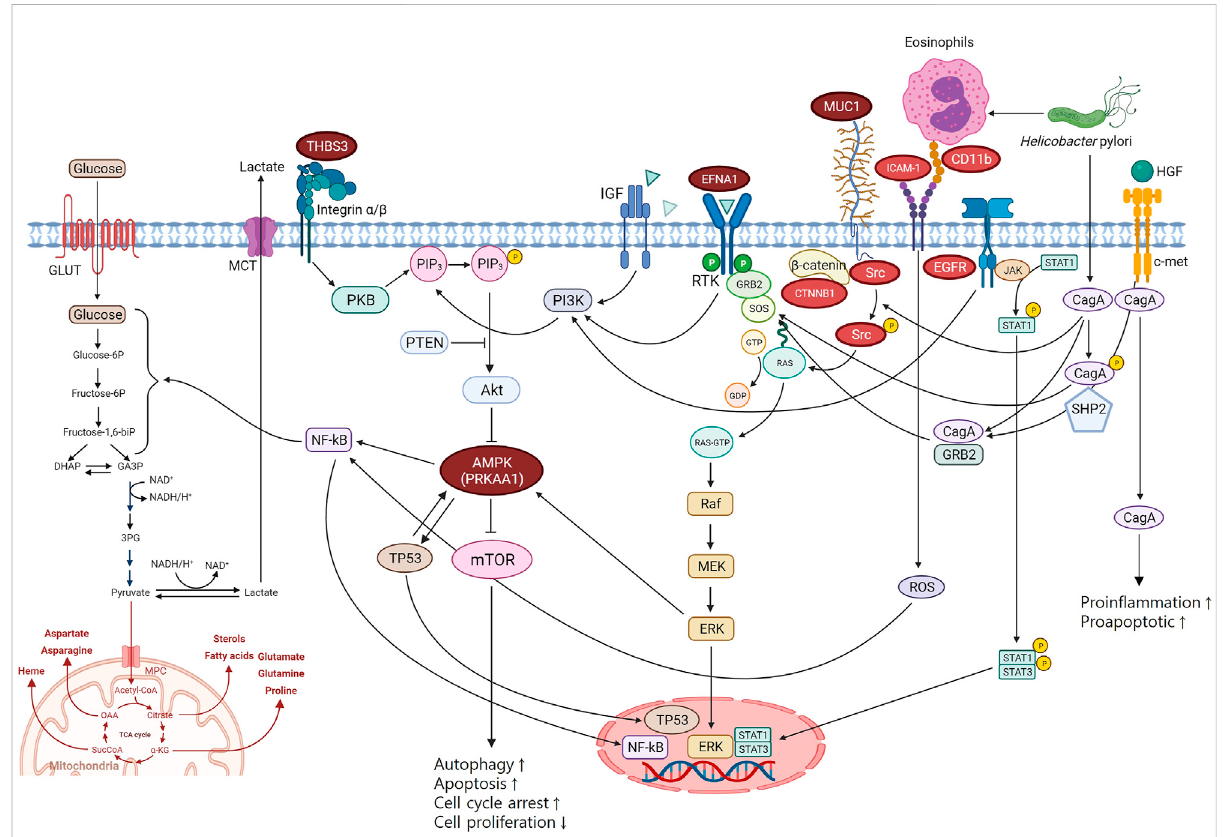
FIGURE 3 Biological pathways of gastric cancer mechanisms. THBS3, EFNA1, and PRKAA1 are involved in PI3K-Alt-mTOR-signaling pathway which is the key pathway associated with gastriccancer. MUC1 interacted with ICAM-1, CD11b, EGFR, Src, and CTNNB1 in PPI network is a regulator of the PI3K- Alt-mTOR-signaling pathway. PPI, protein-protein